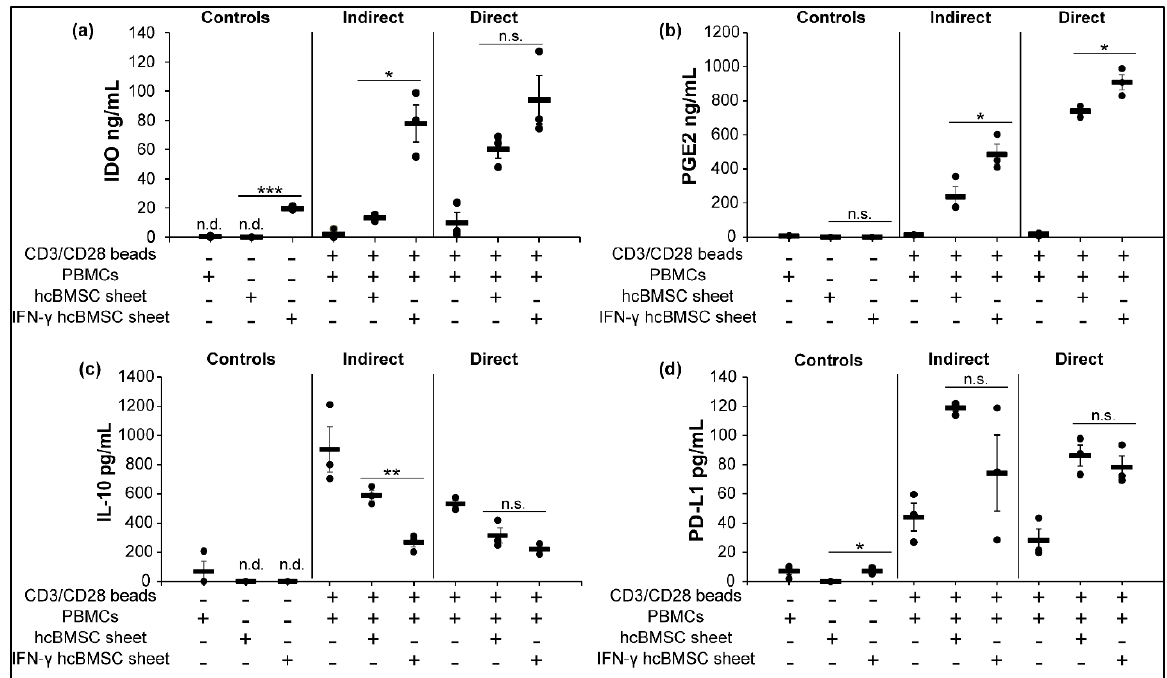
Figure 6. hcBMSC sheet PBMC coculture stimulates production of immunosuppressive factors. Enhanced ( a ) IDO-1, ( b ) PGE2, levels relate to enhanced immunosuppression in hcBMSC sheet coculture groups. ( c ) Decreased IL-10 levels relate to enhanced immunosuppression in hcBMSC sheet coculture groups. ( d ) PD-L1 was upregulated in all cell sheet PBMC coculture groups unrelated to observed immunosuppression. Error bars represent means ± SE ( n = 3, independent experiments) (n.s. p > 0.05, * p < 0.05, ** p < 0.01, *** p < 0.001).